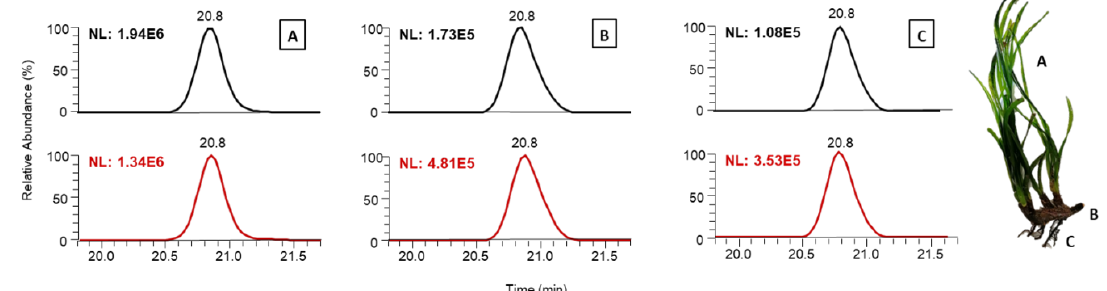
Figure 1. Extracted ion chromatogram for isorhamnetin-3-O-glucoside at 479.11840 m/z in full MS, with R T 20.8 min, for FAN7 tissues: ( A ) leaves, ( B ) rhizomes, and ( C ) roots showing differences in base peak intensities (NL). Black chromato- graphic peaks were obtained using 5:5 v/v extraction mixture and brown peaks correspond to 8:2 v/v extraction mixture.